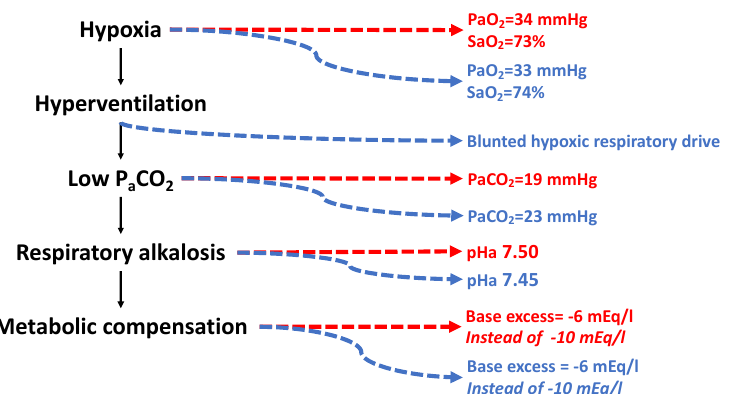
Figure 8. Respiratory adjustment to altitude (6450 m/9.3 %O 2 ) in unacclimatized Caucasians (red) and acclimatized Sherpas (blue). Data from [212,264].